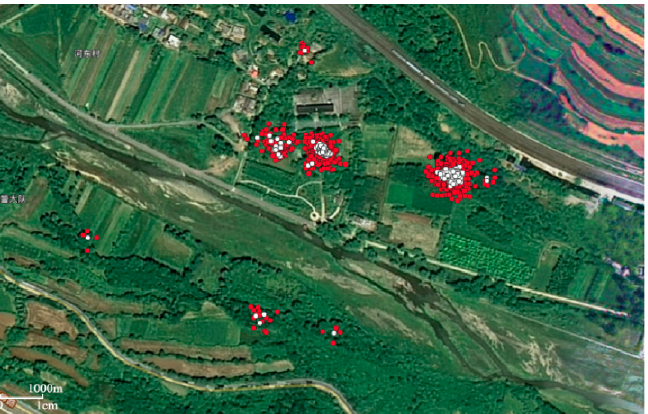
Figure 3. Result of identifying stopping areas using the improved DBSCAN method. Red points represent detected stopping points with high spatial and temporal density. White points are the centroids of many consecutive stopover points.